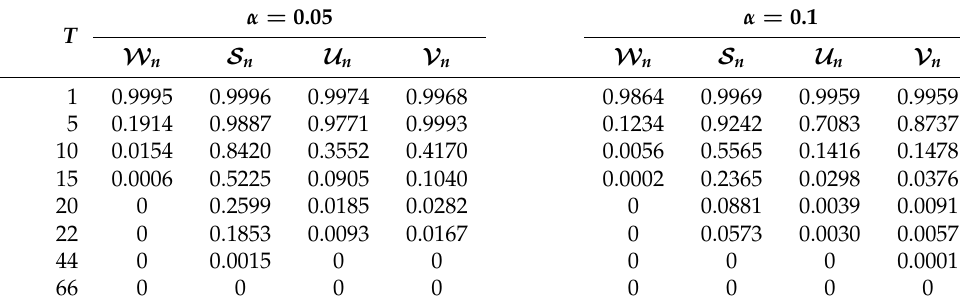
Table 3. Coverage rates of the test statistics under H 1